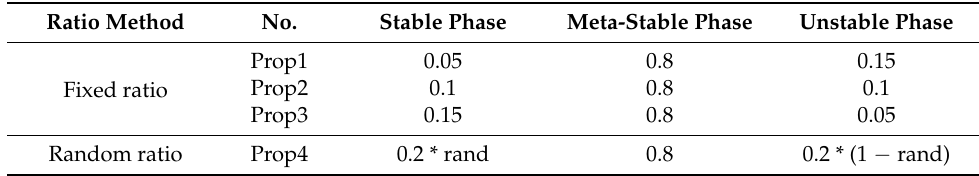
Table 5. Different interval ratio settings of the three